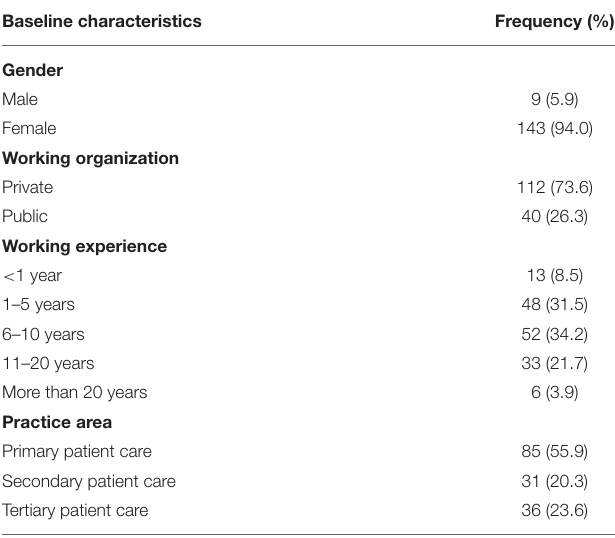
TABLE 1 | Respondents’ demographic